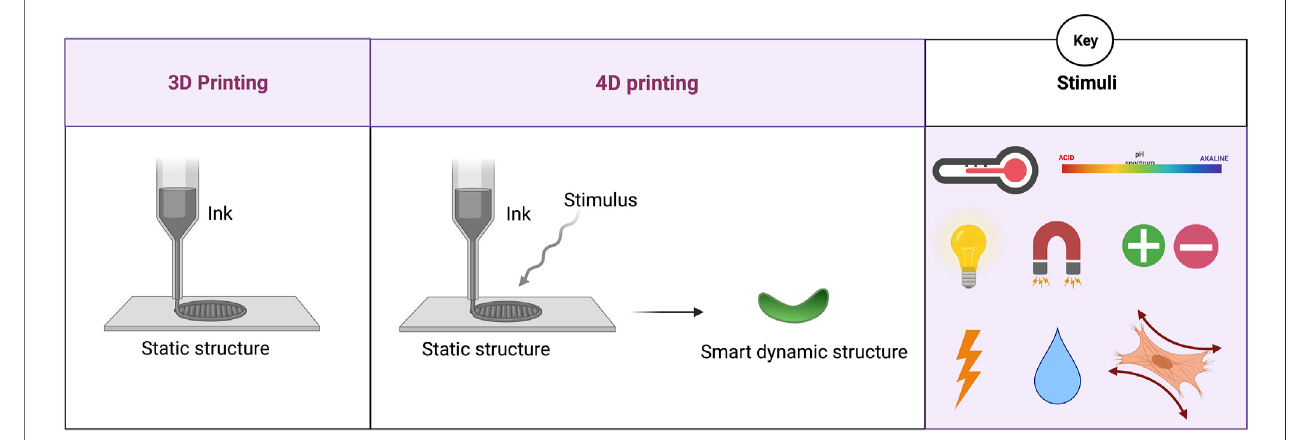
FIGURE 1 | Schematic illustration of 3D printing and 4D printing approaches. Physical, chemical, and biological stimuli are summarized in the key box including temperature, light, electrical and magnetic fi eld, moisture, pH, ions, and cell traction.